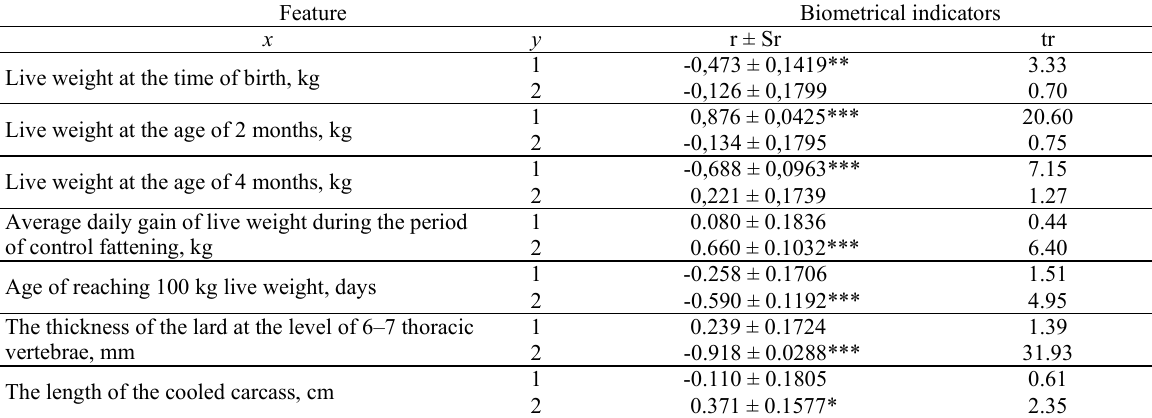
The level of correlations between fattening and meat qualities, the “formation intensity” index (Δt; 0 -2-4), and the Tyler B index, n =